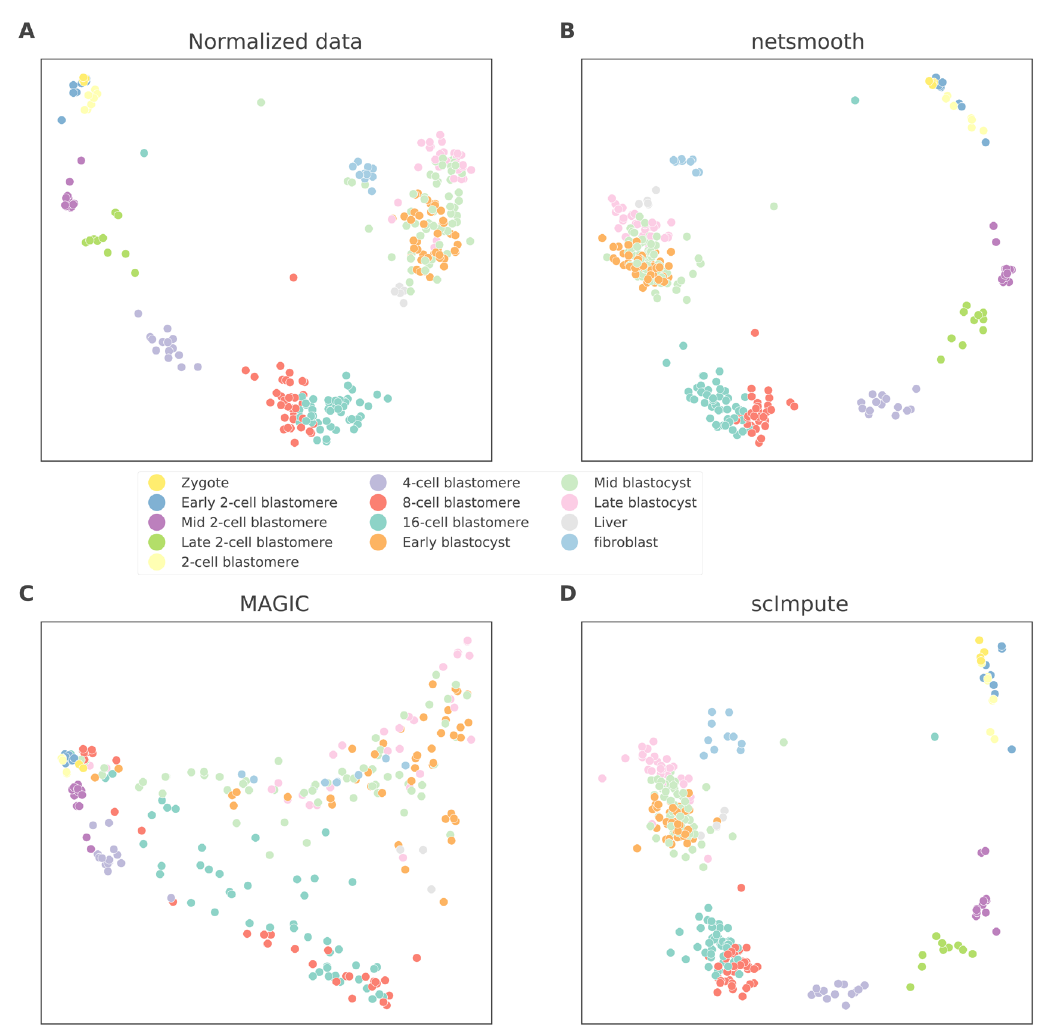
Figure 4. 2D PCA plots of the embryonic development dataset A ) no preprocessing, B ) after application of netSmooth, C ) after imputing missing values with scImpute, and D ) after application of MAGIC. The online version of this figure is